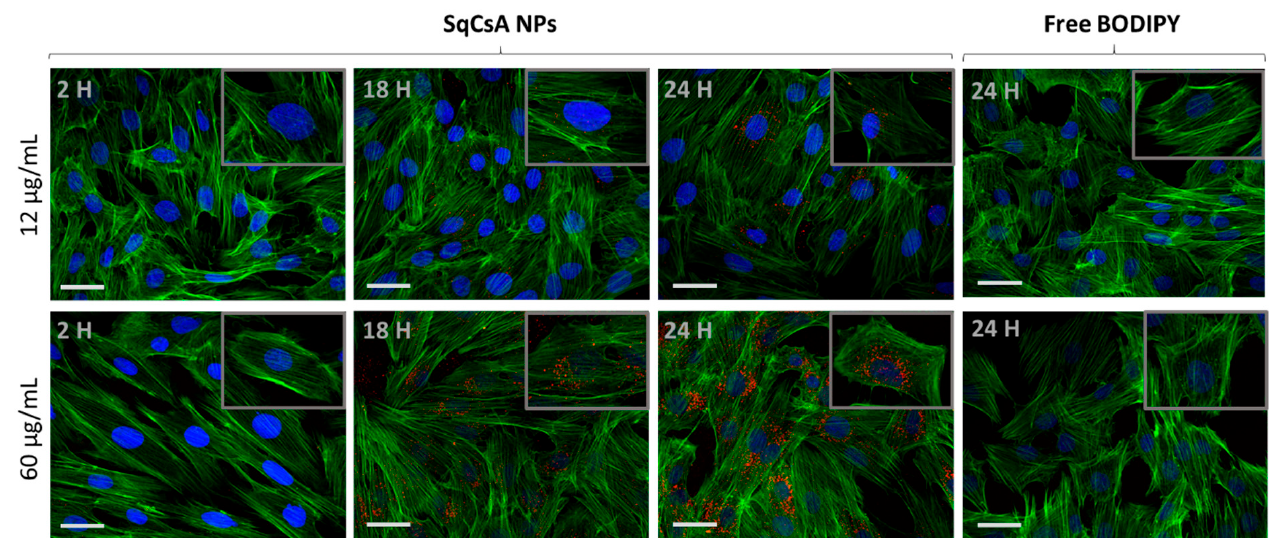
Figure 6. SqCsA NPs uptake assessment. The H9c2 cell line was incubated with two concentrations of nanoparticles 12 or 60 µg/mL loaded with Cholesteryl 4,4-difluoro-5-(4-methoxyphenyl)-4-bora-3a,4a-diaza-s-Indacene-3-undecanoate (CholEsteryl BODIPY™, red). After different times, cells were rinsed, fixed, and incubated with phalloidin (green). The cells were mounted with medium containing 4’,6-diamidino-2-phénylindole (DAPI, blue), analyzed under confocal microscope, and imaged. Cells incubated with only CholEsteryl BODIPY™, at an equivalent concentration to 60 µg/mL of NPs, were used as control and imaged at 24 h. Insert 90× magnification. Scale bar = 50 µm.